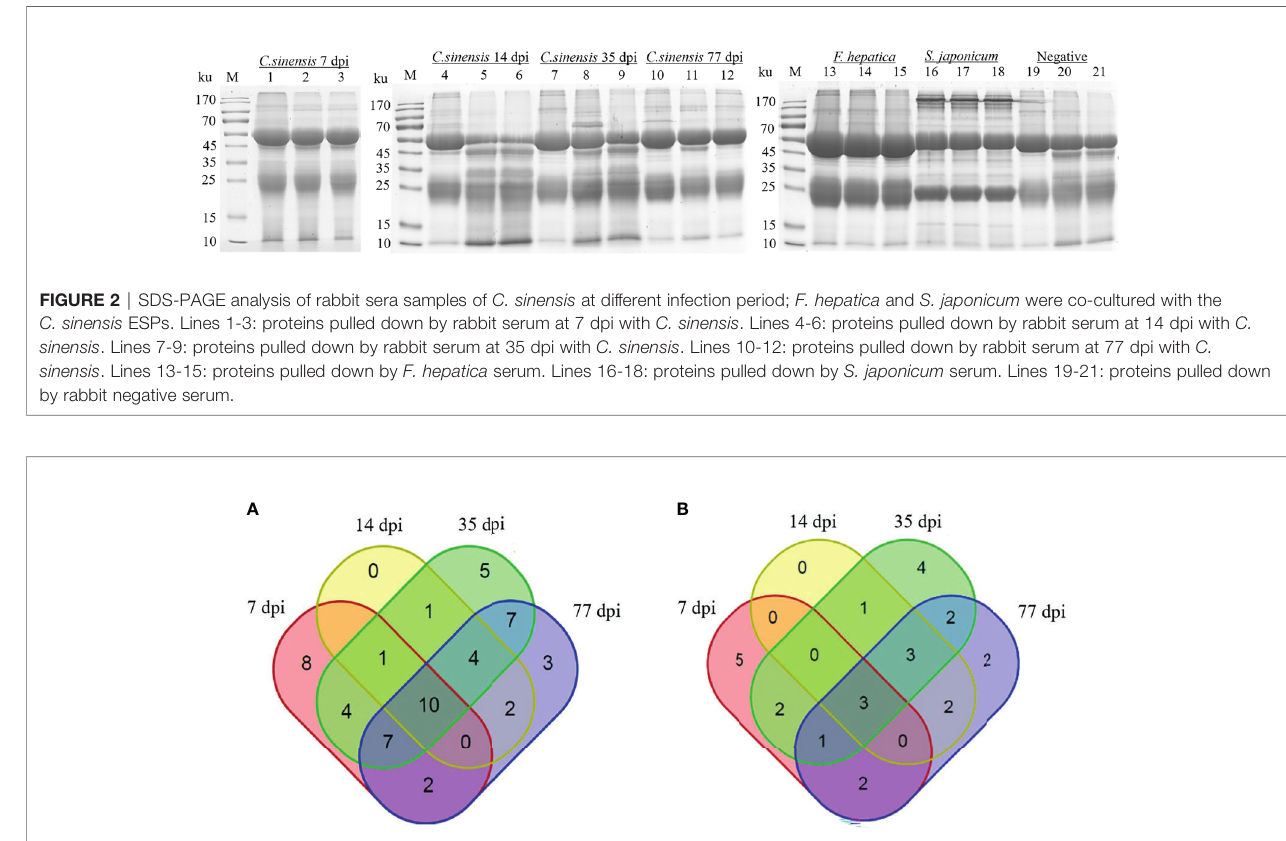
FIGURE 3 | Proteins identi fi ed to be binding to rabbit sera at different infection time points. (A) Proteins speci fi cally identi fi ed to bind to rabbit serum at 7 dpi with C. sinensis (pink), 14 dpi (yellow), 35 dpi (green) and 77 dpi (blue), compared with negative serum. (B) Proteins speci fi cally identi fi ed to bind to rabbit serum at 7 dpi with C. sinensis (pink), 14 dpi (yellow), 35 dpi (green), and 77 dpi (blue), compared with S. japonicum serum, F. hepatica serum, and negative serum.